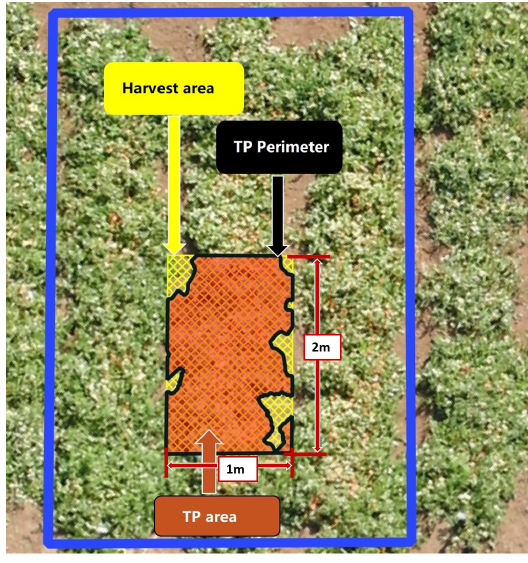
Figure 5. Harvest area and their